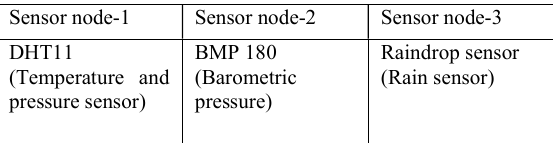
Table 2. Grouped sensor nodes under various